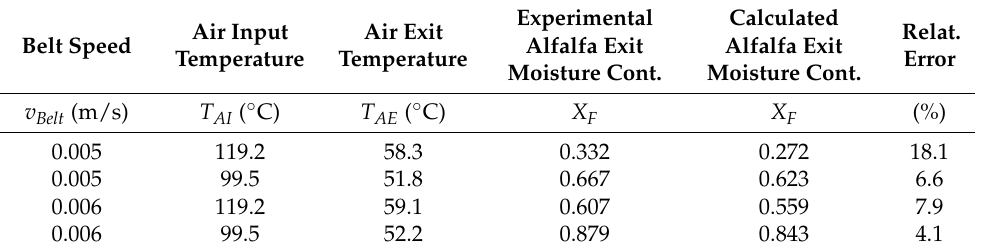
Table 3. Alfalfa experimental moisture content values at the exit dryer vs. calculated ones by Equation